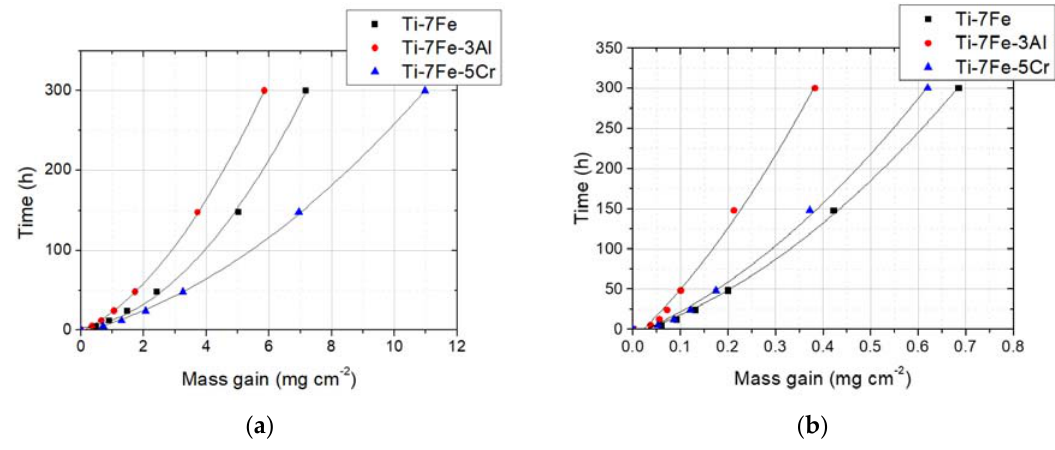
Figure 15. Monceau parabolic fit time vs. mass gain at ( a ) 600 °C and ( b ) 500 °C.